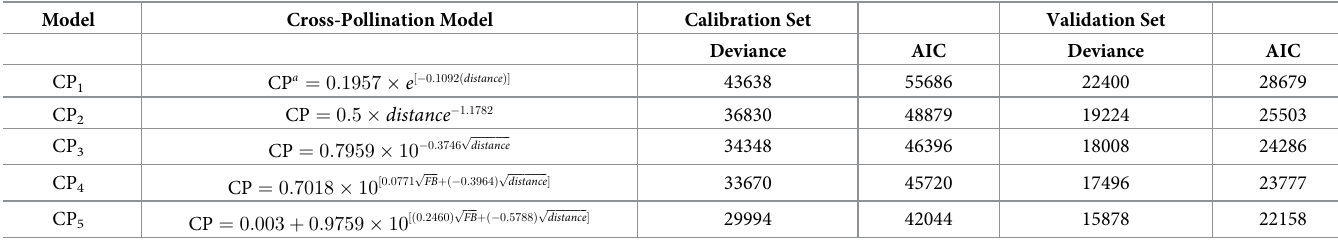
Table 3. Deviance and AIC for each model in the calibration and validation sets.